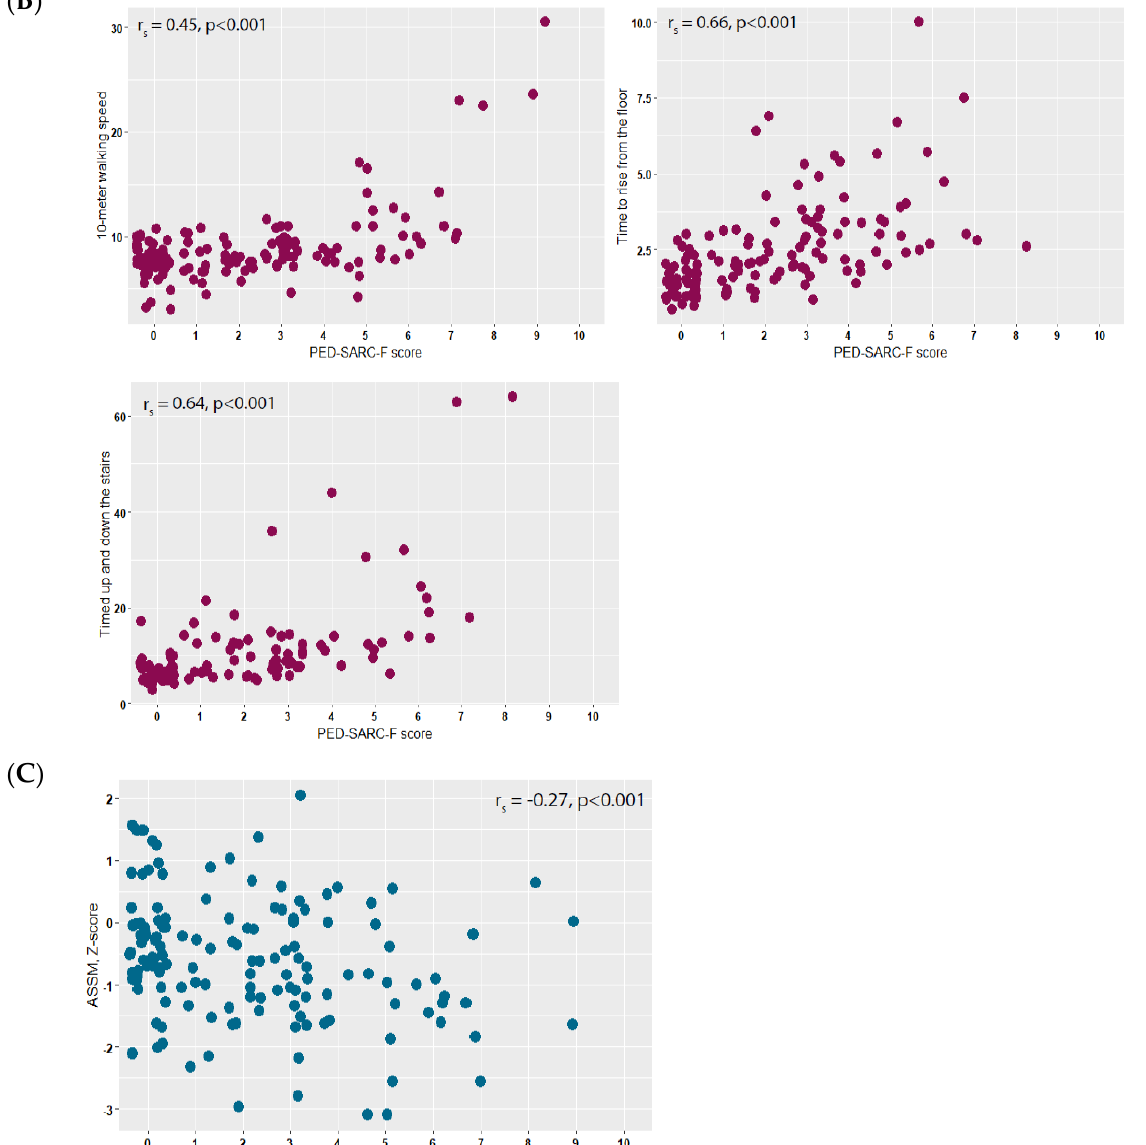
Figure 1. ( A ). Scattergraphs showing muscle strength measures by PED-SARC-F score; ( B ). Scattergraphs showing physical performance tests by PED-SARC-F score; ( C ). Scattergraph showing appendicular skeletal muscle mass (ASMM) by PED-SARC-F score. Abbreviations: r s = Spearman’s correlation coefficient.